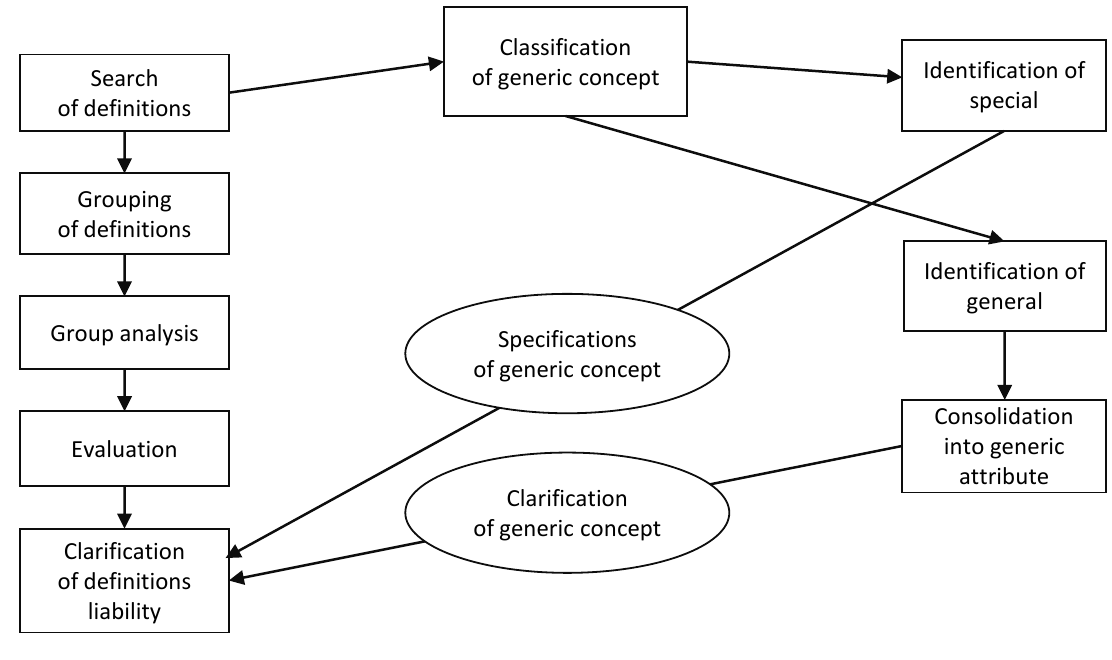
Figure 2. Chain of